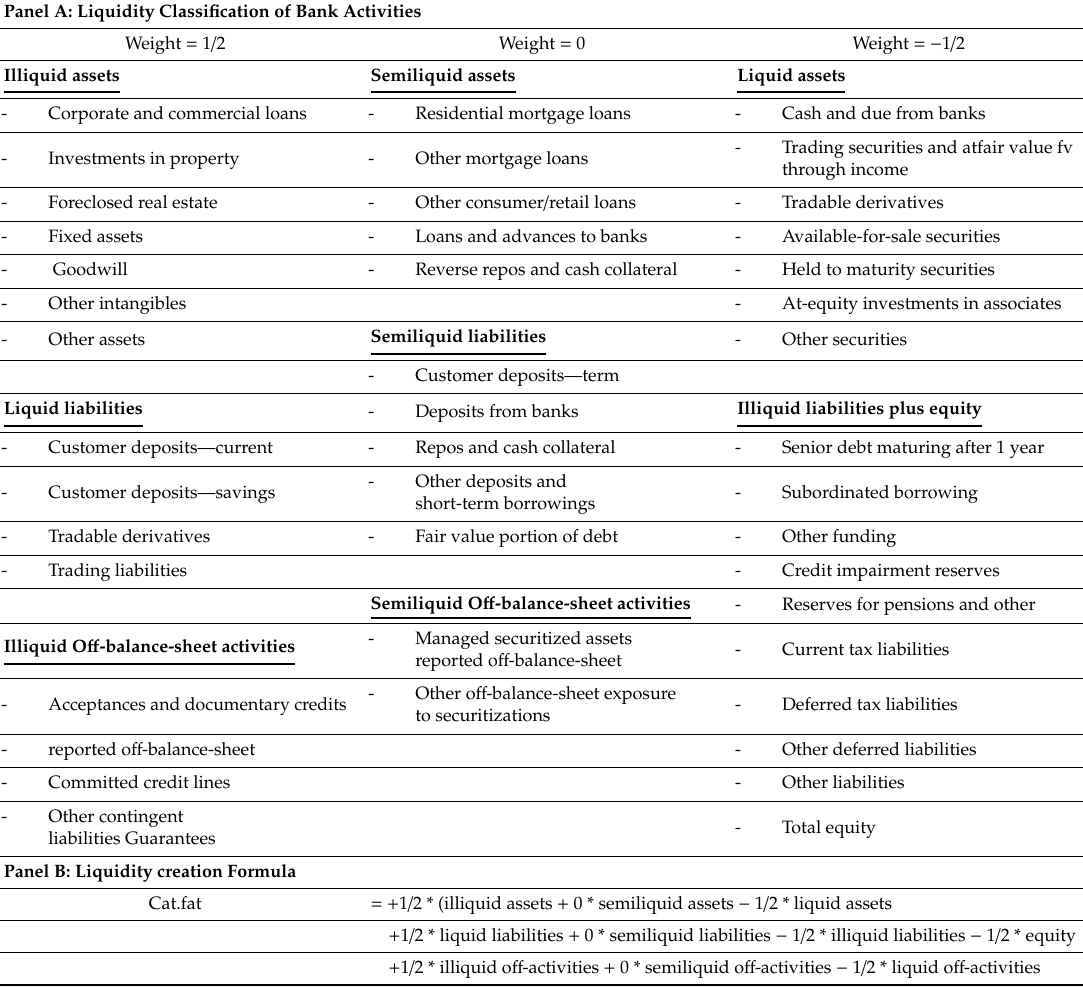
Table 3. Liquidity classification of bank activities and construction of cat.fat liquidity creation measure. Panel A: Liquidity Classification of Bank Activities